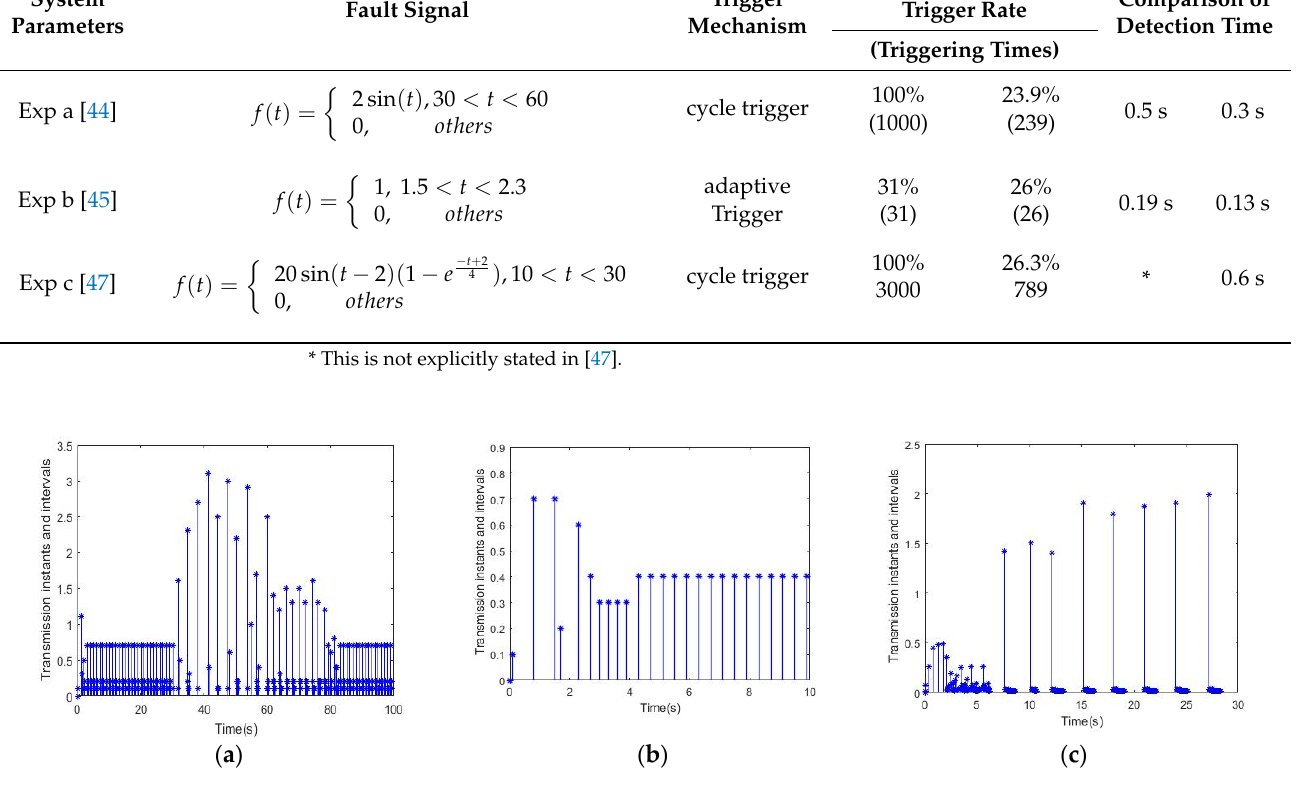
Figure 6. Transmission instants and intervals for experiment ( a – c ).